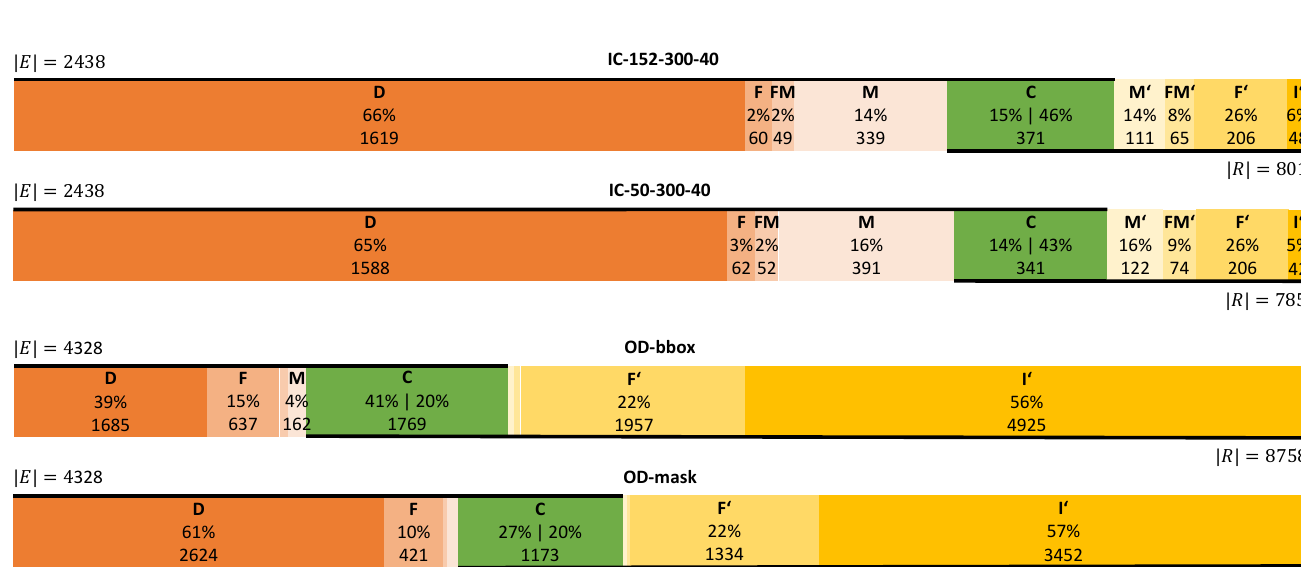
Figure 4. EAD diagrams visualizing the event based error classes with respect to ground truth events | E | and returned events | R |